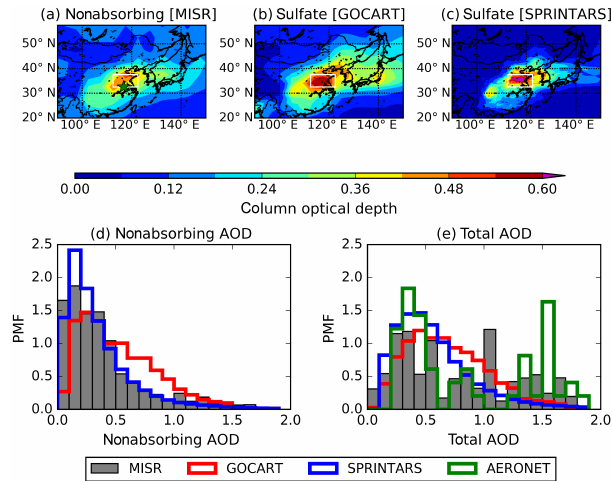
Figure 2. (a) Climatological mean optical depth of the spherical nonabsorbing aerosol components in MISR, sulfate aerosol optical depth in (b) GOCART, and (c) SPRINTARS over East Asia for July. Data from the eight Julys between 2000 and 2007 are averaged for MISR and GOCART. Spatiotemporal distributions of (d) the nonab- sorbing (or sulfate) AOD and (e) total AOD from MISR (gray bars), from GOCART (red lines) and from SPRINTARS (blue lines), covering the boxed emission source region (112.5–122.5 ◦ E, 32.5– 37.5 ◦ N) are displayed. The green star in (a) displays a location of the AERONET station in Shouxian. The green line in (e) represents the total AOD distribution in Shouxian for July